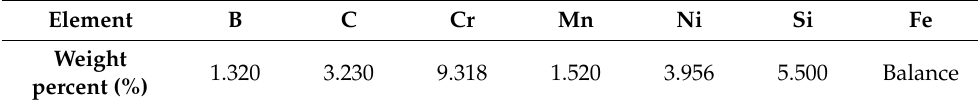
Table 1. Chemical composition of the metallic powder. Element